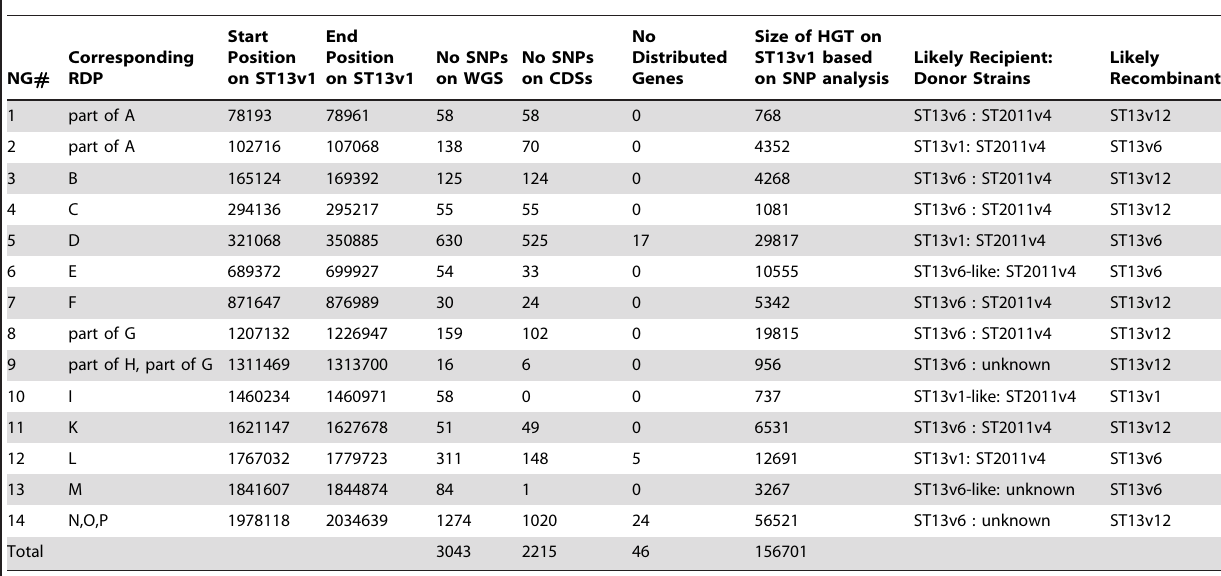
Table 4. Genic and allelic differences identified with large ( . 500 bp) regions of horizontal gene transfer among S. pneumoniae isolates from a single